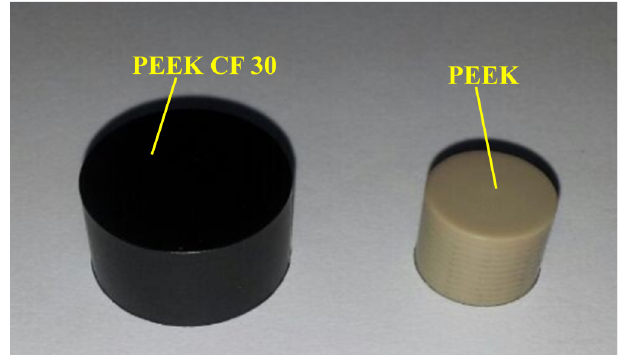
Figure 1. Composite materials.